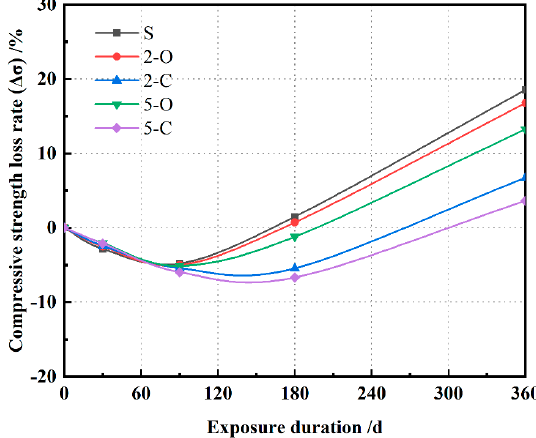
Figure 7. Compressive strength loss rates of samples under sulfate attack.